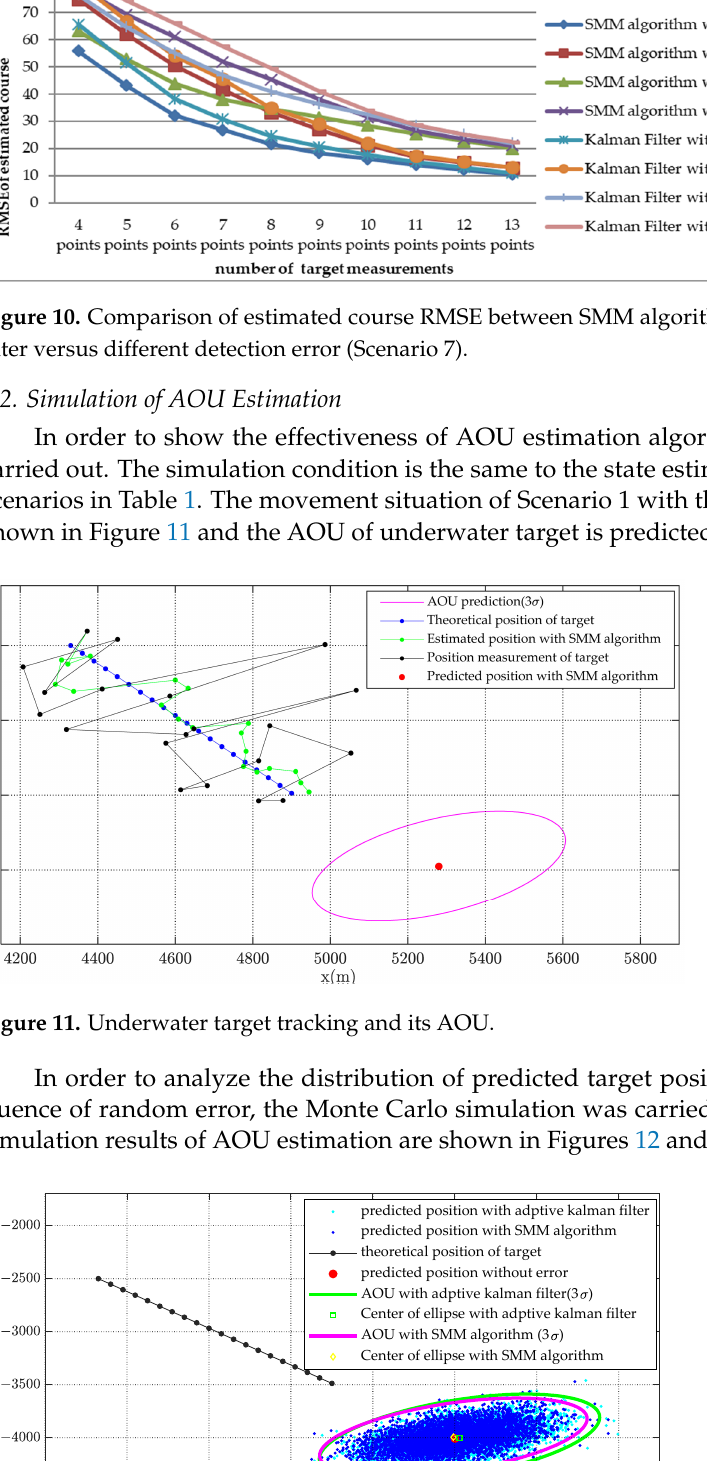
Figure 9. Comparison of estimated velocity RMSE between SMM algorithm and adaptive Kalman filter versus different detection error (Scenario 7).